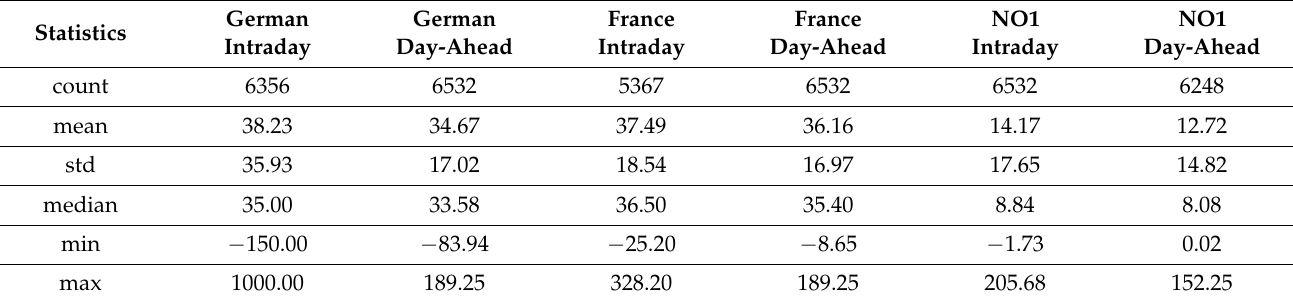
Table 1. General Statistics across all Price Categories in MWh/EUR.